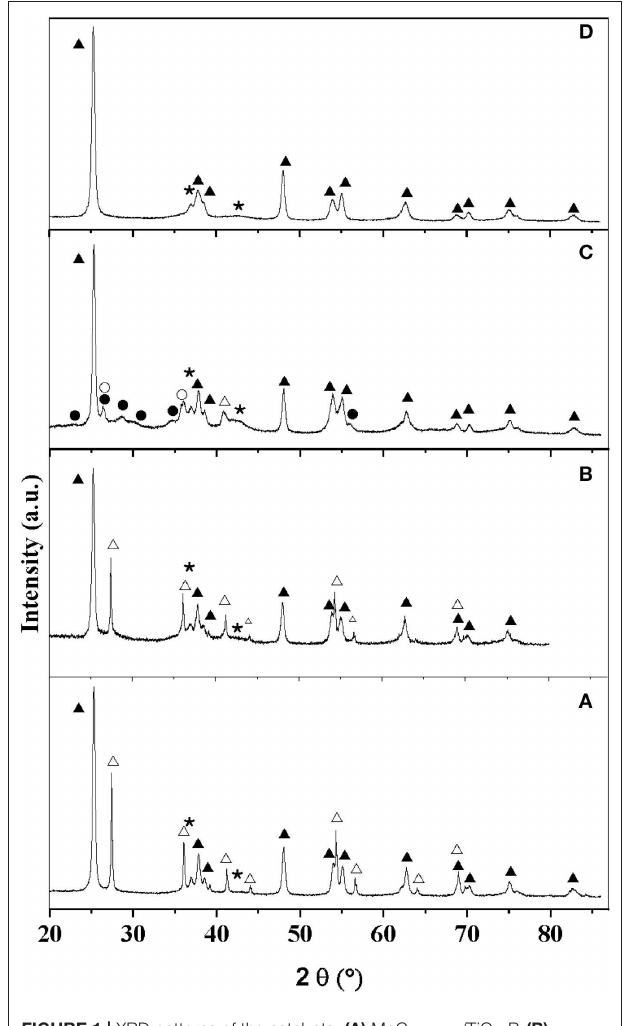
FIGURE 1 | XRD patterns of the catalysts: (A) MoC 10E − 700 /TiO 2 - P, (B) MoC/TiO 2 - P, (C) MoC 20E − 800 /TiO 2 - P, and (D) MoC 20E − 700 /TiO 2 -D. Assignment of peaks: ( N ) anatase, ( △ ) rutile, ( • ) Ti 5 O 9 , ( (cid:13) ) Ti 4 O 7 , and ( ⋆ )